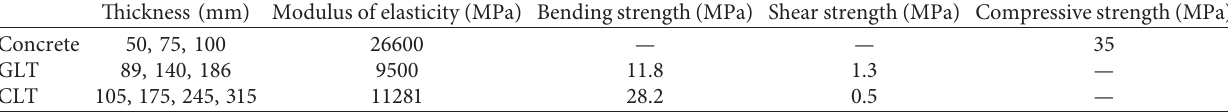
Table 1: Design properties of the concrete and